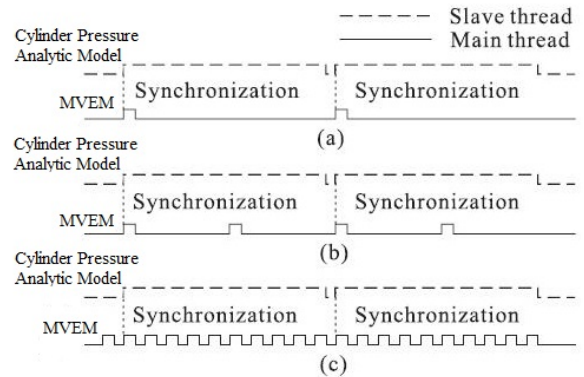
Figure 21. Synchronization approach for the MVEM and the cylinder pressure analytic model: ( a ) X = 0; ( b ) X = 1; ( c ) the calculation frequency of the MVEM is many times the analytic model.